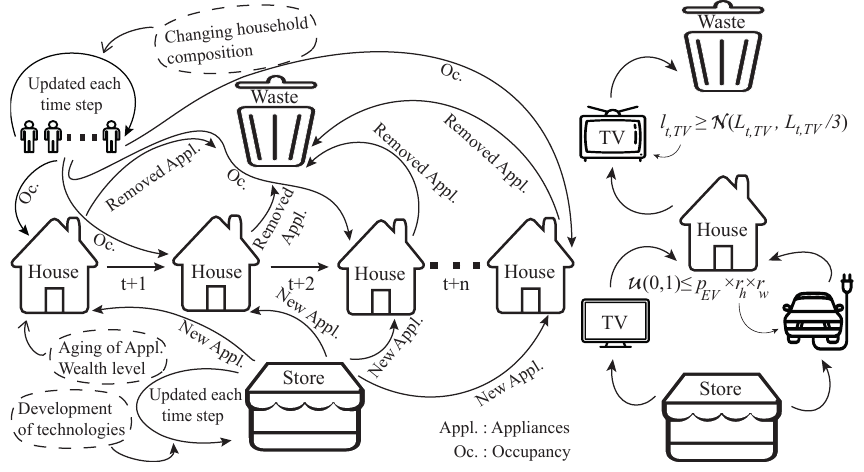
Figure 7. The update of household